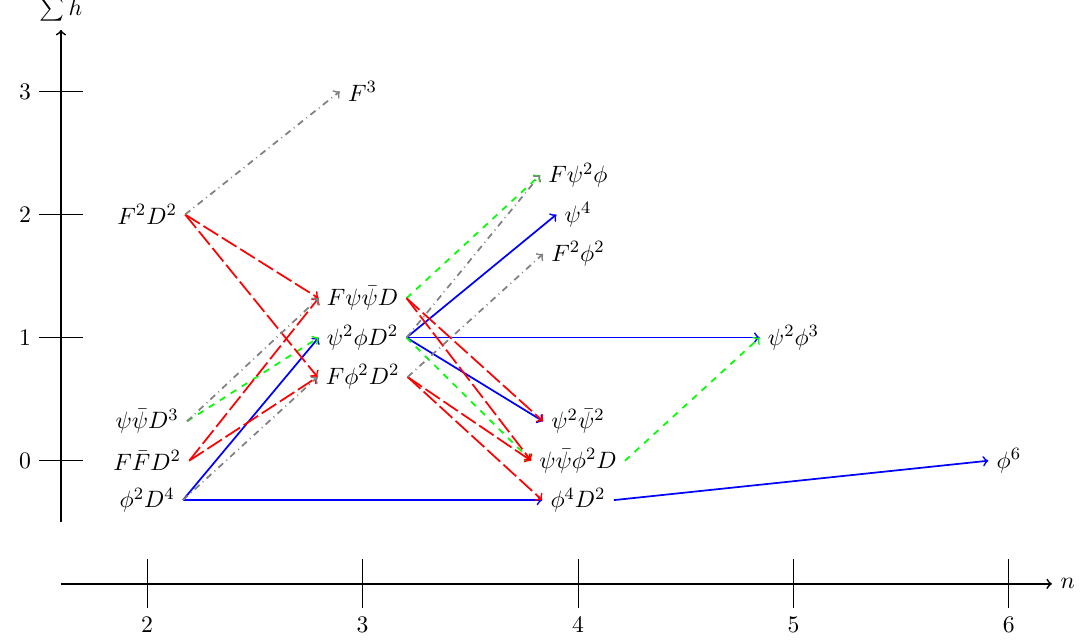
Figure 3 . A schematic ‘map’ of all dimension 6 operators allowed by Lorentz symmetry, cut in half about its axis of symmetry P h = 0 (re(cid:13)ected in this line are the hermitian conjugates of the operators shown). Arrows show the movement induced by equation of motion relations and commutation of derivative relations in the space of dim 6 operators, colour-coded to show (cid:30) EOMs (blue), EOMs (green, short dashed), F EOMs (red, long dashed), and replacing derivatives with (cid:12)eld strengths (grey,